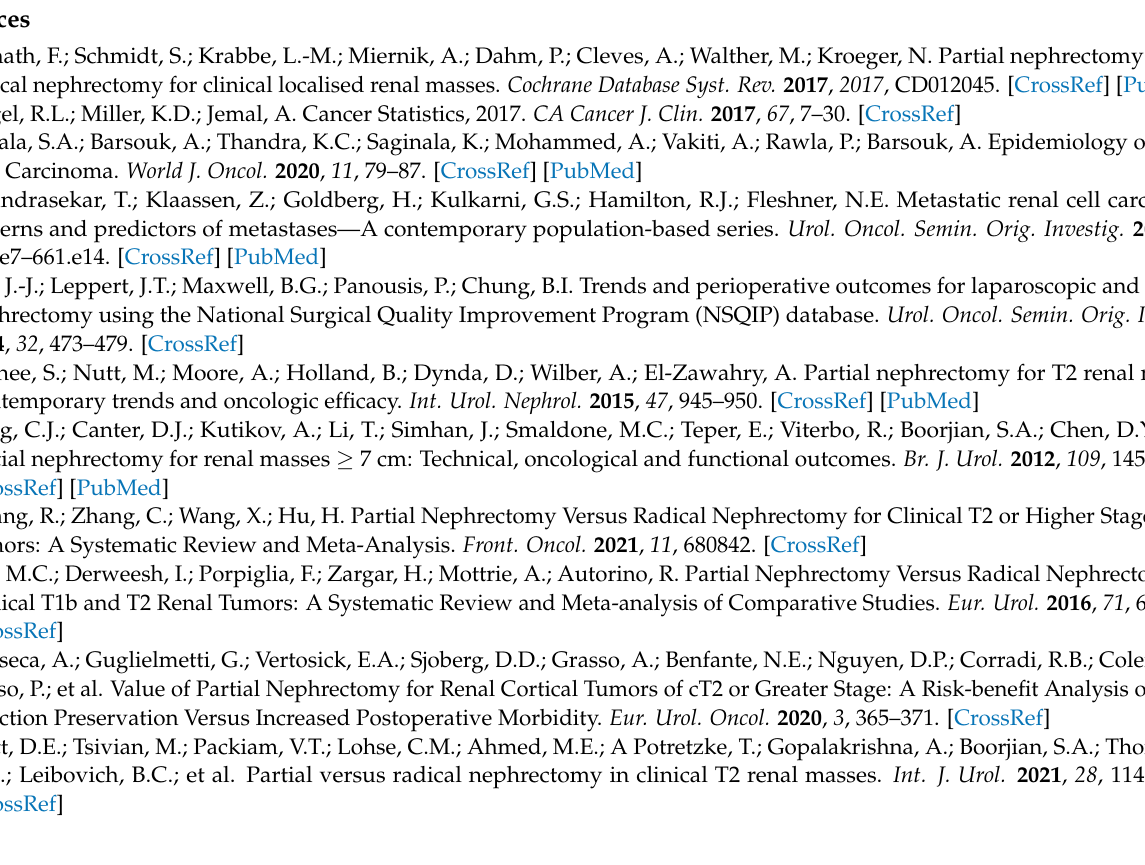
Table S2. Multivariate analysis of associations between patient factors and complications of interest following partial nephrectomy, Supplemental Table S3. Multivariate analysis of associations between patient factors and complications of interest following radical